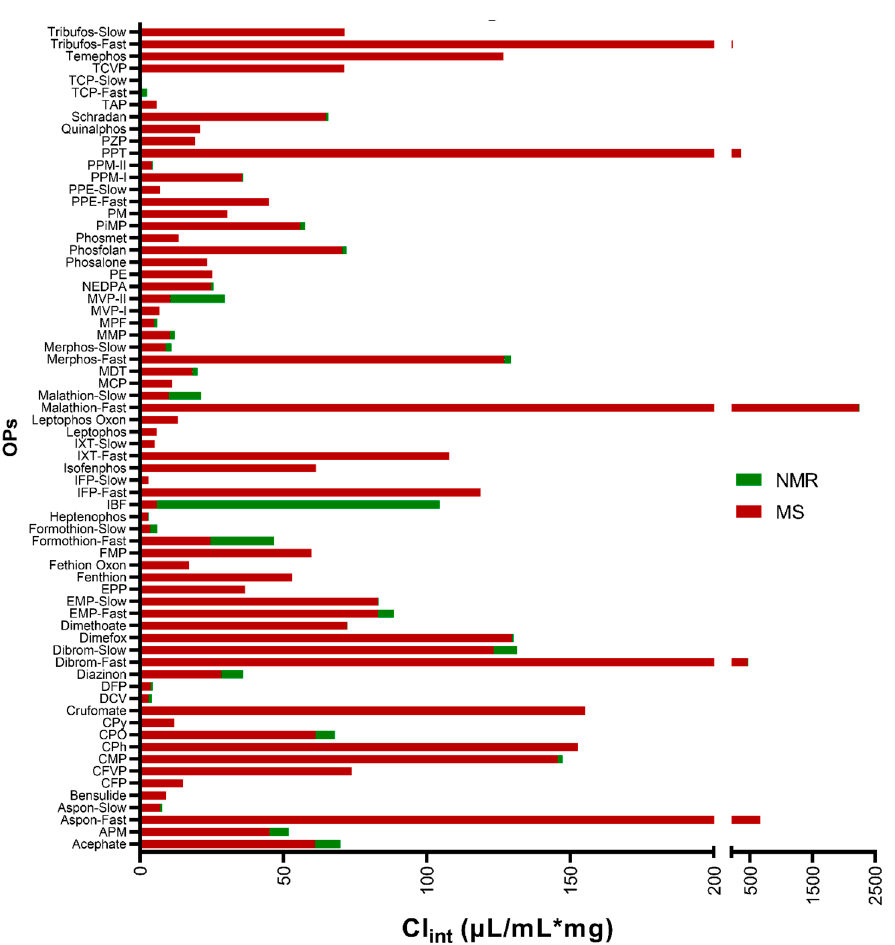
Figure 1. Comparison of the intrinsic clearance rates of OPs in HLMs calculated from data obtained at low- and high-dose regimen experiments.